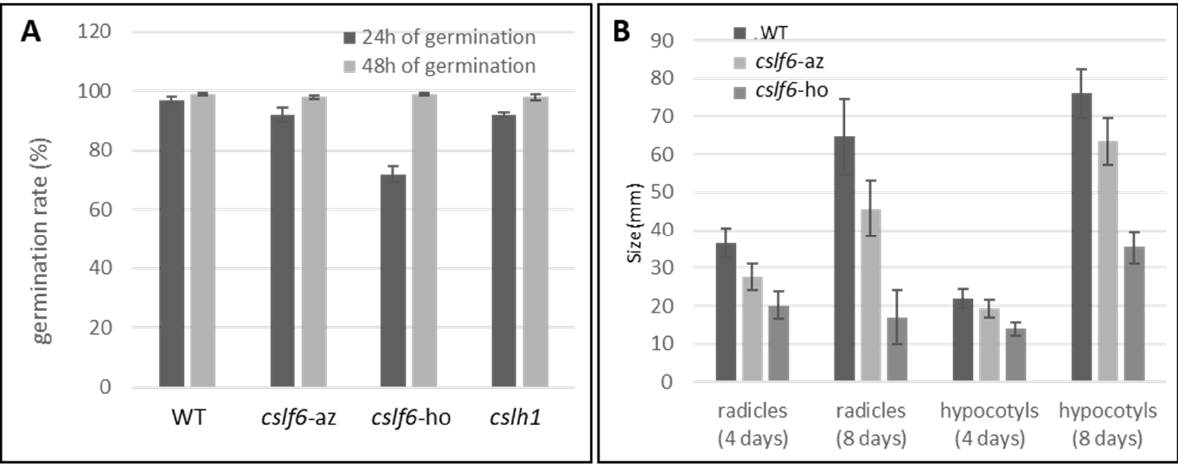
Figure 9. Development of germinated lines. ( A ). Germination rate at 24 and 48 h of germination of cslf6 and cslh1 mutants and controls (WT and azygous cslf6 ). ( B ). Size of radicles and hypocotyls of a cslf6 mutant compared to controls (WT and azygous cslf6 ). n = 100 grains. cslf6 -ho: homozygous cslf6 mutant; cslf6 -az: azygous cslf6 mutant.